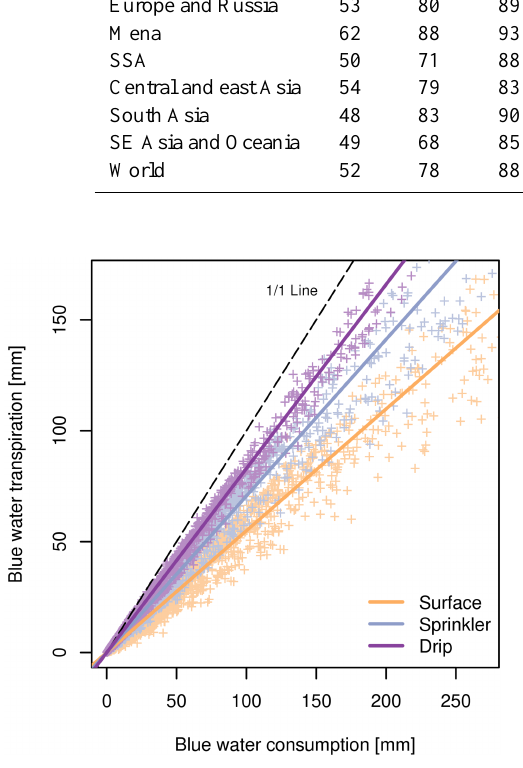
Figure 8. Relation of blue water consumption and blue water tran- spiration for the three scenarios all-surface, all-sprinkler, all-drip, and each grid cell, compared to the 1/1